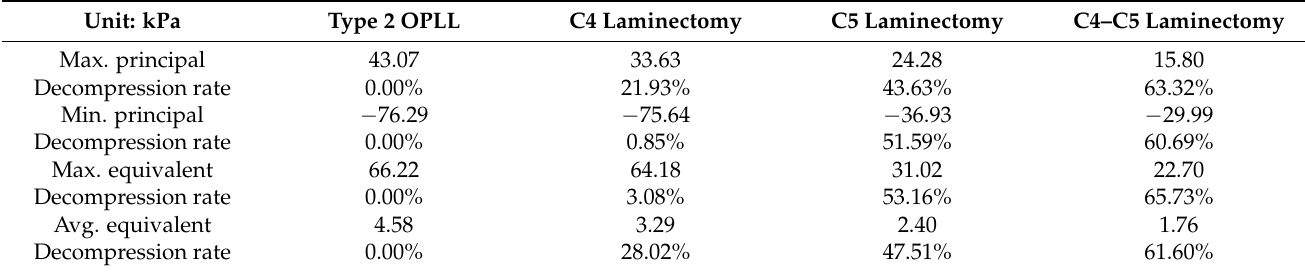
Table 5. Neutral laminectomy simulation spinal cord stresses: type 2 OPLL.